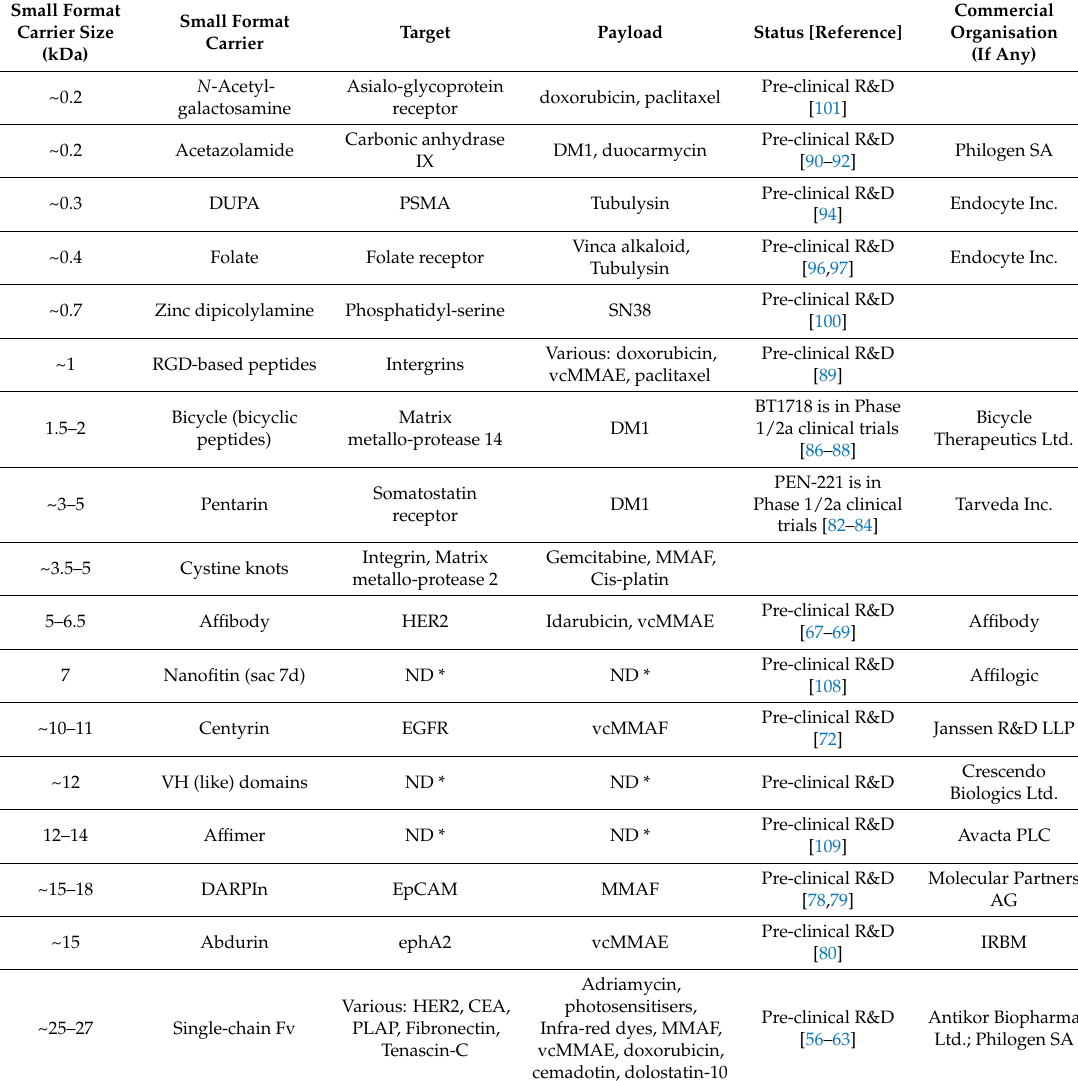
Table 1. Summary of the various small-format drug conjugates in clinical and pre-clinical development. Small Format Carrier